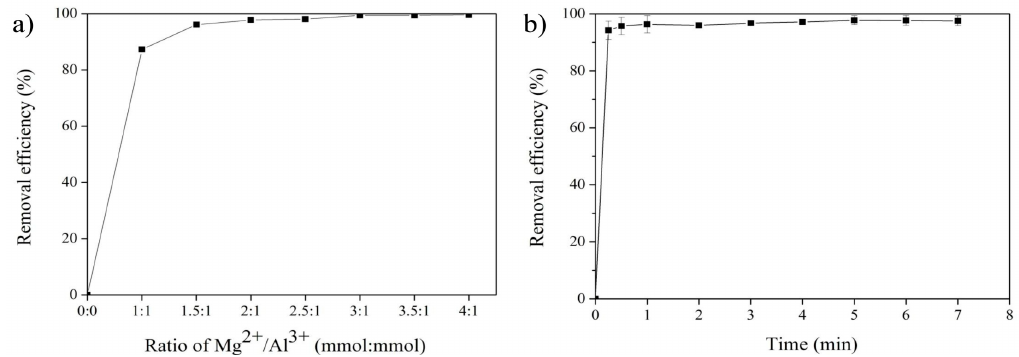
Figure 2. The effect of ( a ) the volume of 1 M NaOH and ( b ) the volume of mixed metal solution on the removal efficiency of TC in aqueous solution at an initial concentration of 30 mg L − 1 .